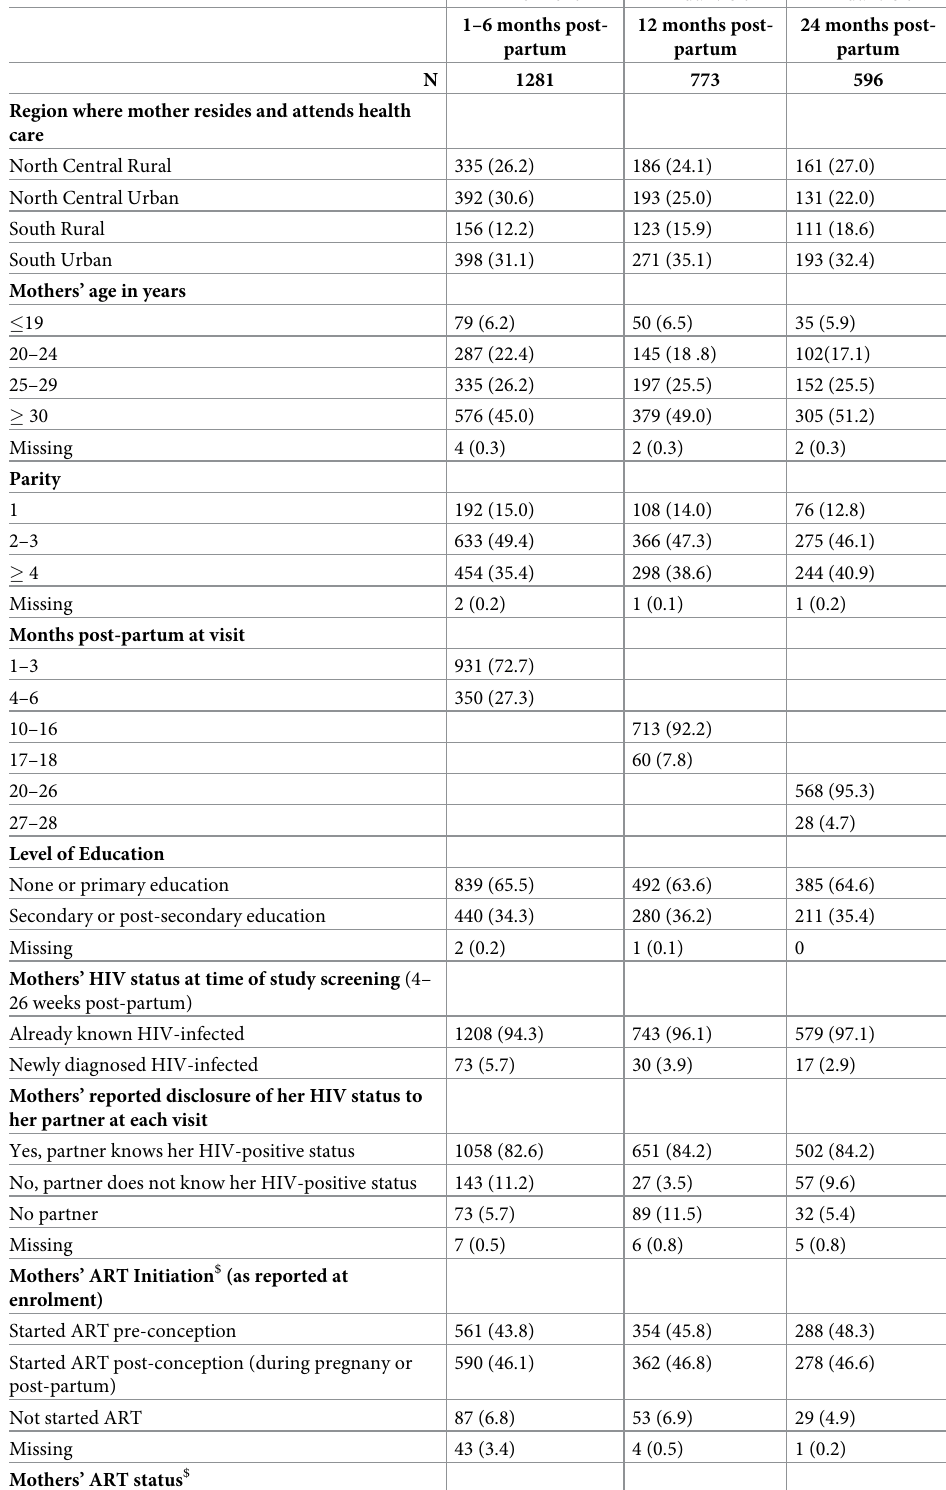
Table 1. Characteristics of HIV-infected mothers enrolled for follow-up to 24